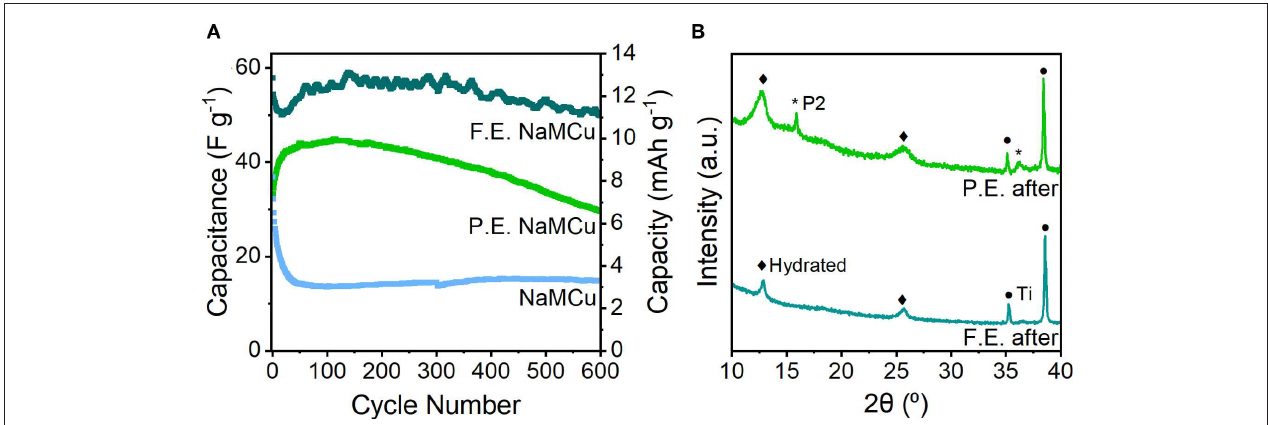
FIGURE 6 | (A) Cycling stability of F.E., P.E., and P2 NaMCu over 600 cycles at 10 mV/s. (B) Ex situ XRD after 600 cycles shows that the F.E. NaMCu retains the hydrated phase, while some of the remaining P2 material in the P.E. NaMCu electrode expanded after prolonged